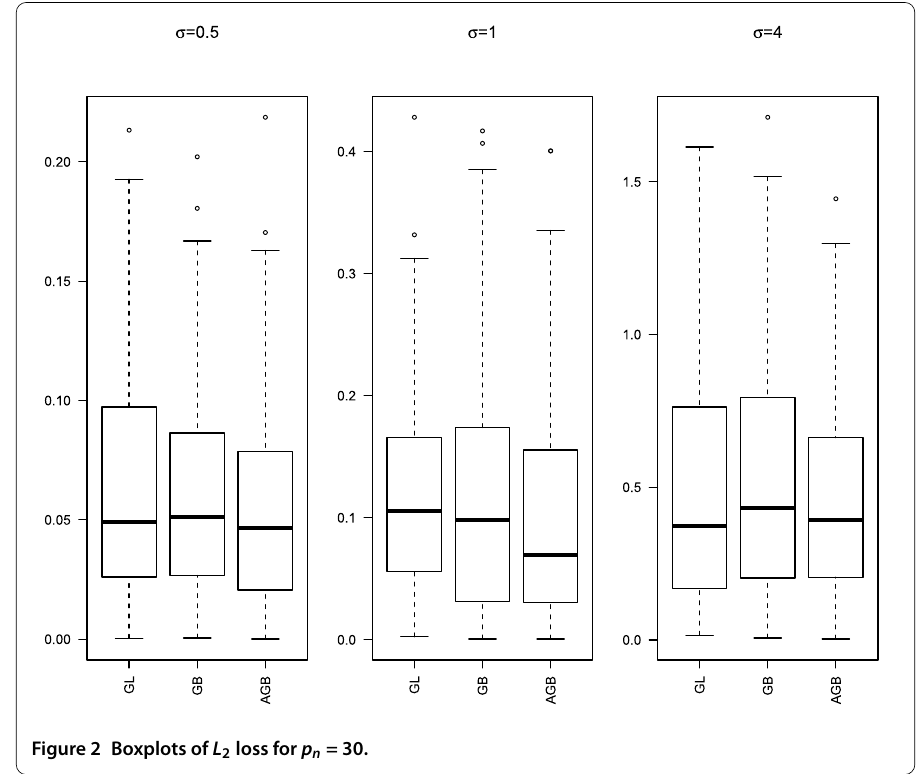
Figure 2 Boxplots of L 2 loss for p n = 30.